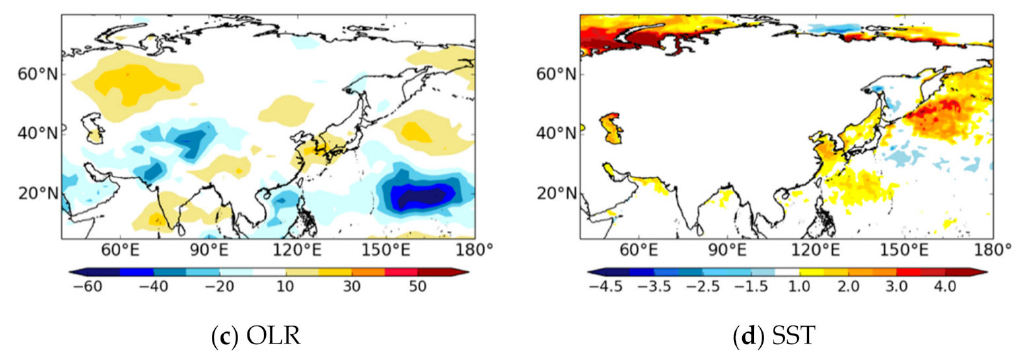
Figure 1. ( a ) Anomalies of geopotential height at 500 hPa (shaded) with climatology (contour), anomalies of ( b ) 1.5 m temperature (K), ( c ) outgoing longwave radiation (OLR) (W / m 2 ) and ( d ) SST (K) averaged on August 2016. Anomalies (shading) are calculated relative to the August monthly mean from 1981 to 2010. ( a , b ) is calculated from European Centre for Medium-Range Weather Forecasts (ECMWF) ERA-Interim atmospheric reanalysis [22] and ( c ) is calculated from the National Oceanic and Atmospheric Administration (NOAA) satellite-derived OLR [23]. ( d ) is calculated from the optimum interpolation sea surface temperature